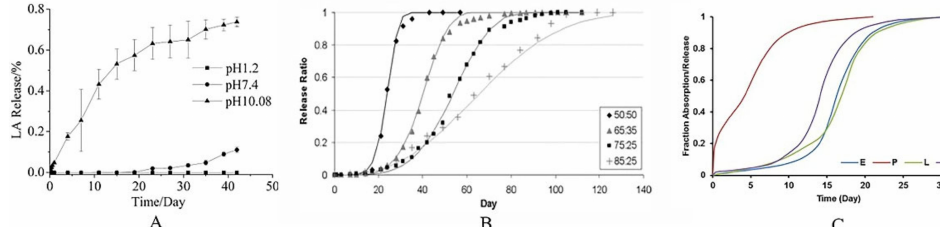
Figure 2. ( A ), Comparison of PLGA degradation rates under different pH conditions [30]. Copyright 2008, Wiley. ( B ), Comparison of PLGA degradation rates for different monomer ratios [31]. Copyright 2010, Springer Nature. ( C ), Comparison of the degradation rates of PLGAs with different intrinsic viscosities; the magnitude of the intrinsic viscosities of the four PLGAs is P < L < E < M [32]. Copyright 2022,